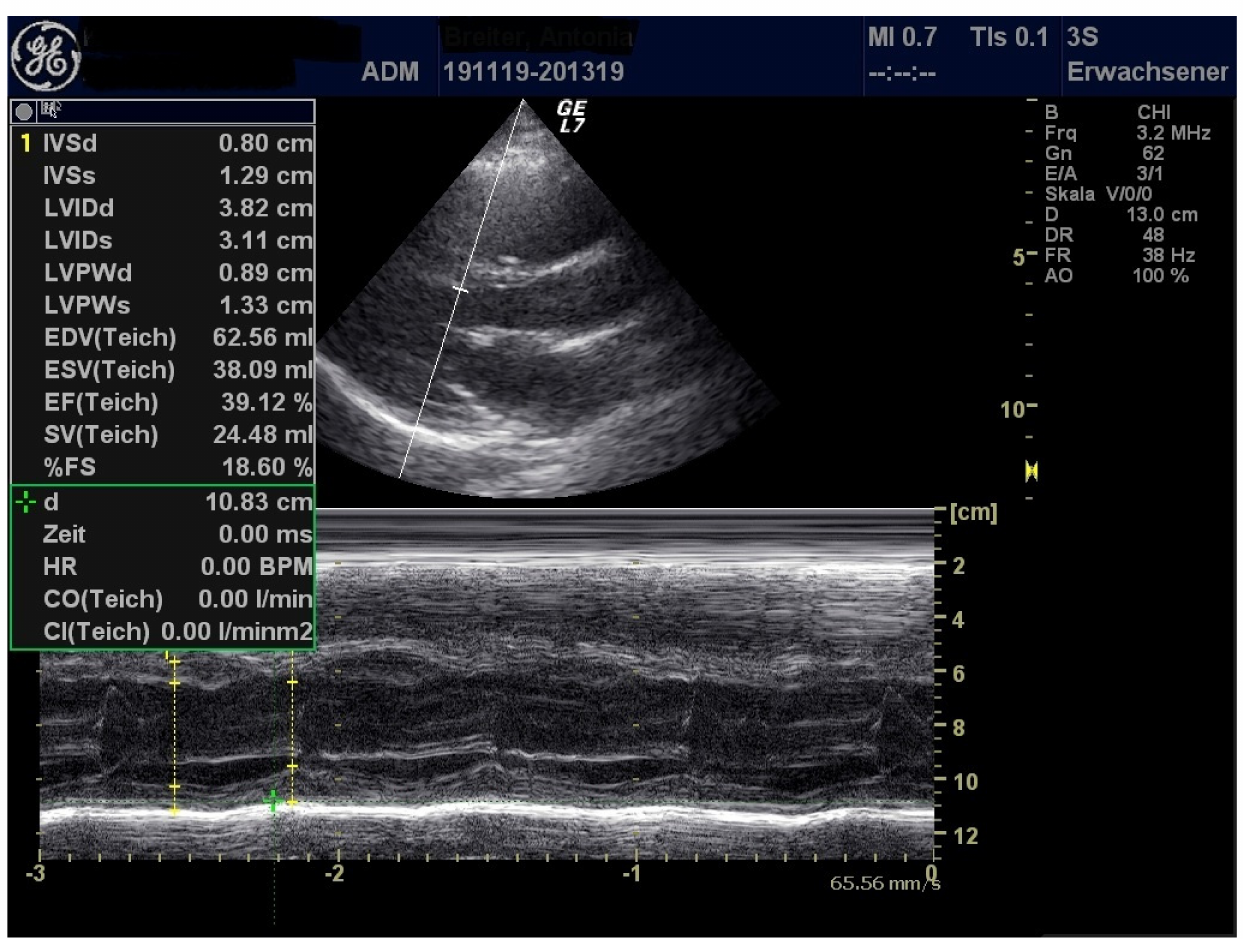
Figure 2. Diminished left ventricular